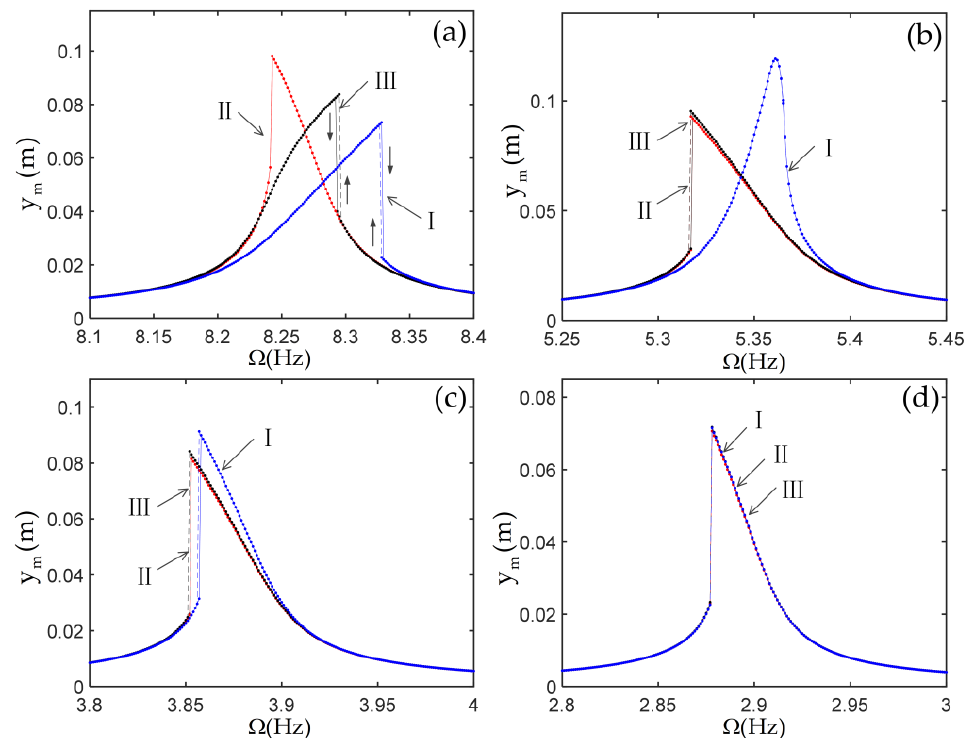
Figure 8. The frequency response curves of vertical displacement of the tip mass: ( a ) m = 0,J = 0; ( b ) m = 0.2,J = 0.004; ( c ) m = 0.5,J = 0.01; ( d ) m = 1,J =